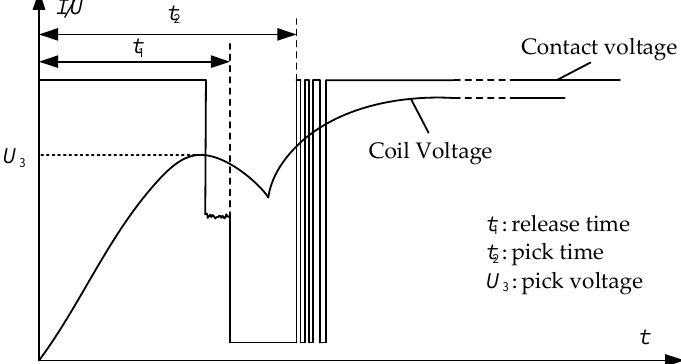
Figure 13. Selected features according to the physics working process of the PMA.